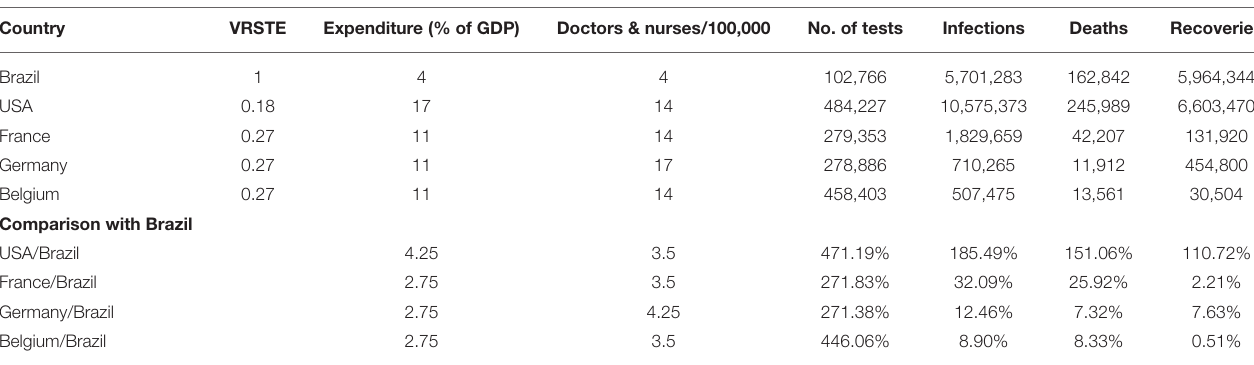
TABLE 2 | Inputs and outputs relative to the benchmark country (Brazil).